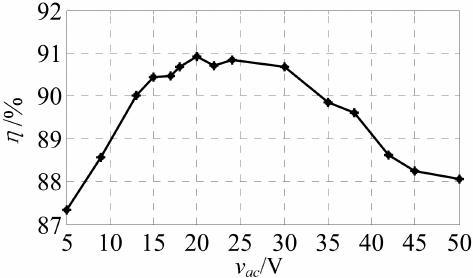
Figure 24. Efficiency curve of AC–DC